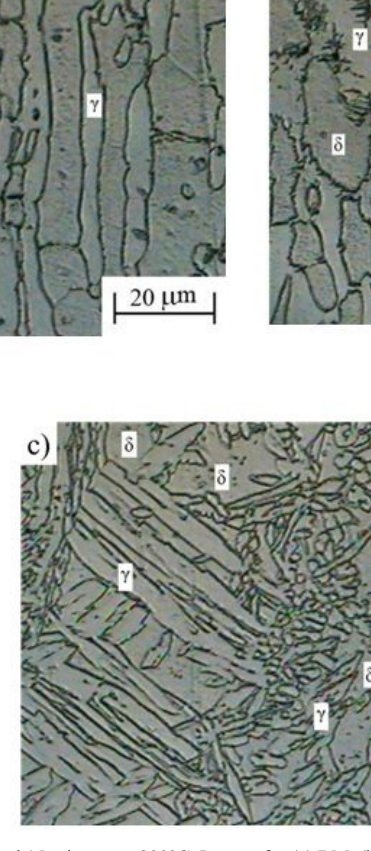
Figure 3. Microstructure of WJ1 treated 15 minutes at 800°C. Images for (a) BM, (b) FL and (c) WMC regions. Reagent: